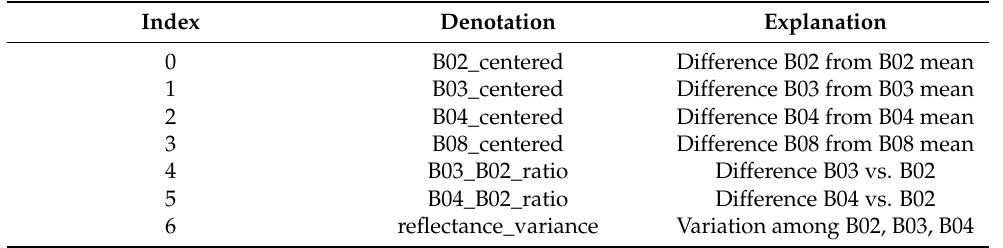
Figure 5. Target object visualized using different band combinations and spatial resolutions: ( a ) B04, B03, B02, ( b ) B08, B03, B02, ( c ) B04, B03, B02, ( d ) B8A, B11, B12, ( e ) B05, B06, B07. Table 1. Random forest features.